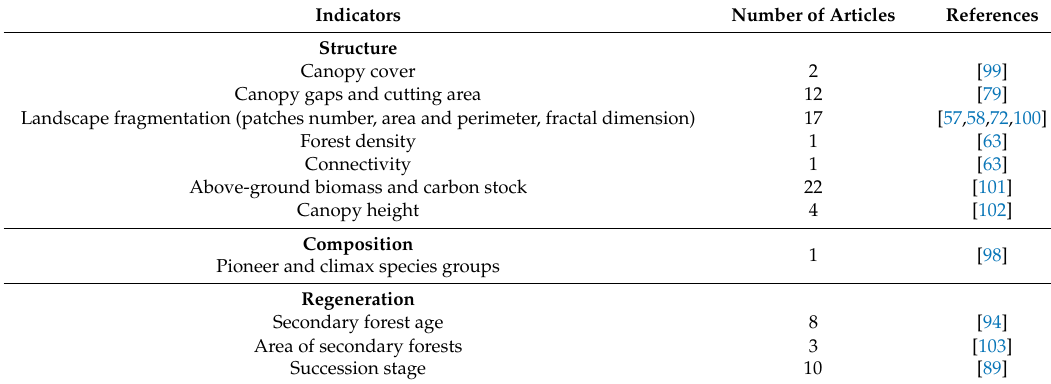
Table 2. Indicators of composition, structure and regeneration with the number of articles using them and examples in the references